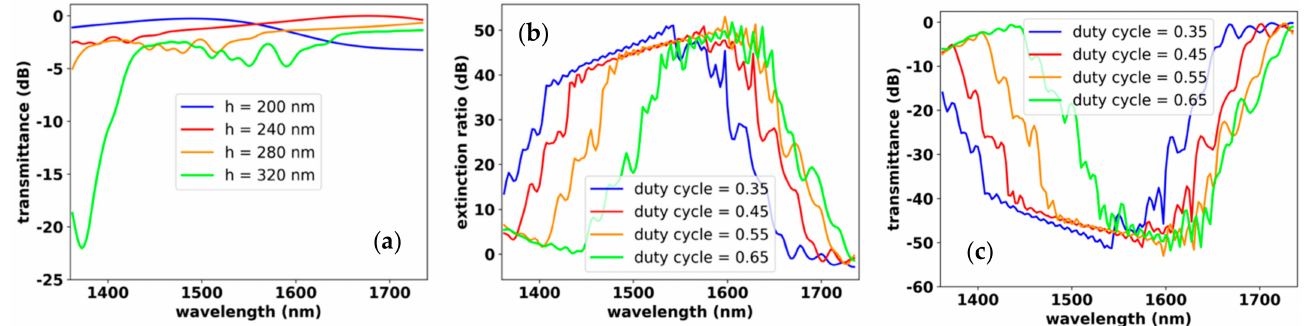
Figure 8. ( a ) The wavelength-dependent transmittances of the TM polarization state under various device heights; ( b ) The wavelength-dependent extinction ratio of the proposed polarizer under various duty cycles. ( c ) The wavelength transmittances of the TE polarization state under various duty